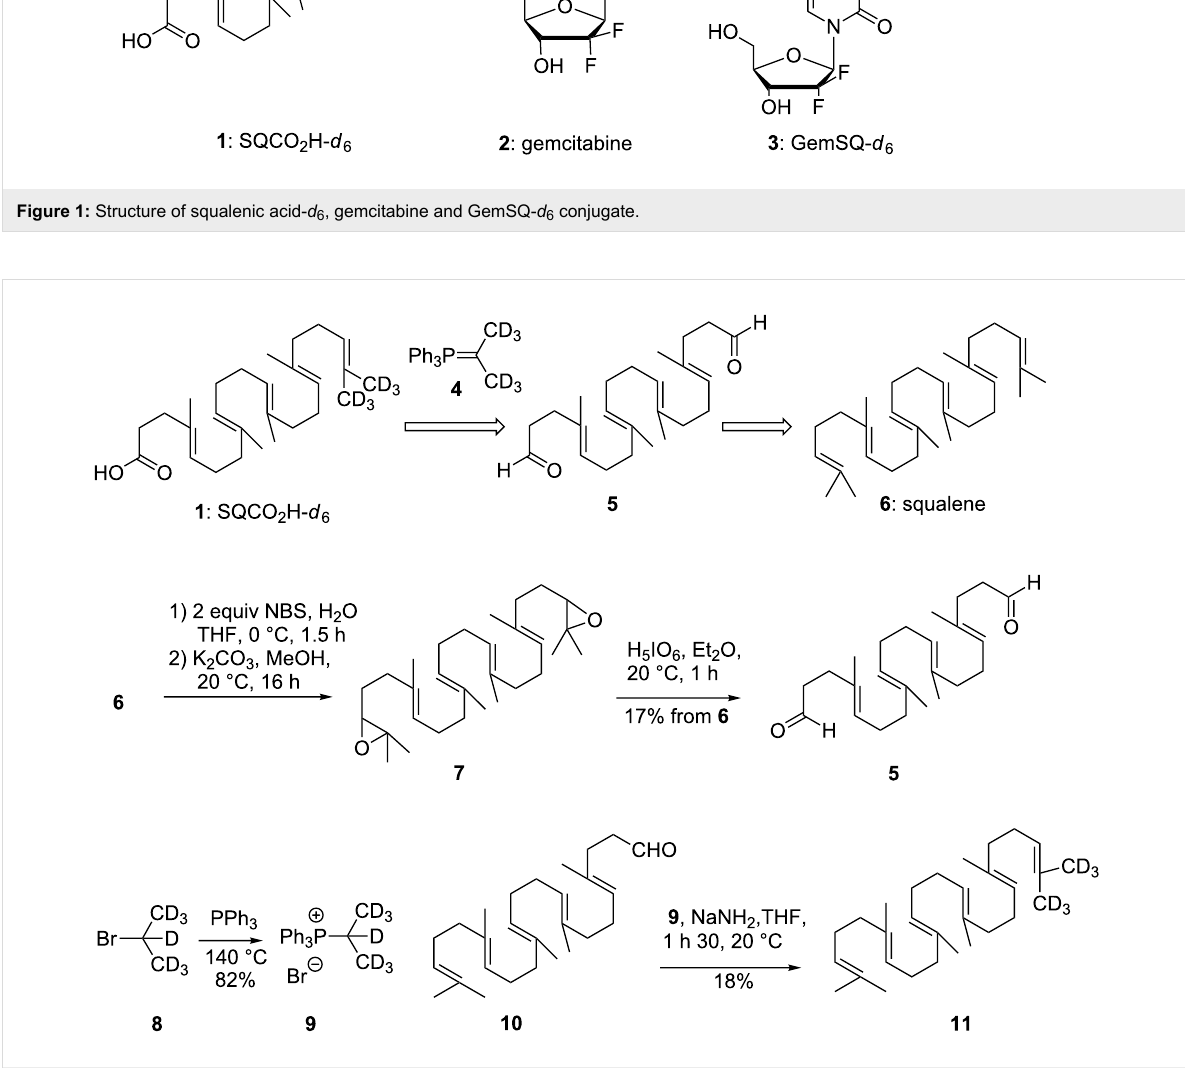
Scheme 1: Retrosynthetic route to SQCO 2 H- d 6 ( 1 ) and synthetic routes for the preparation of dialdehyde 5 and squalene- d 6 11 .